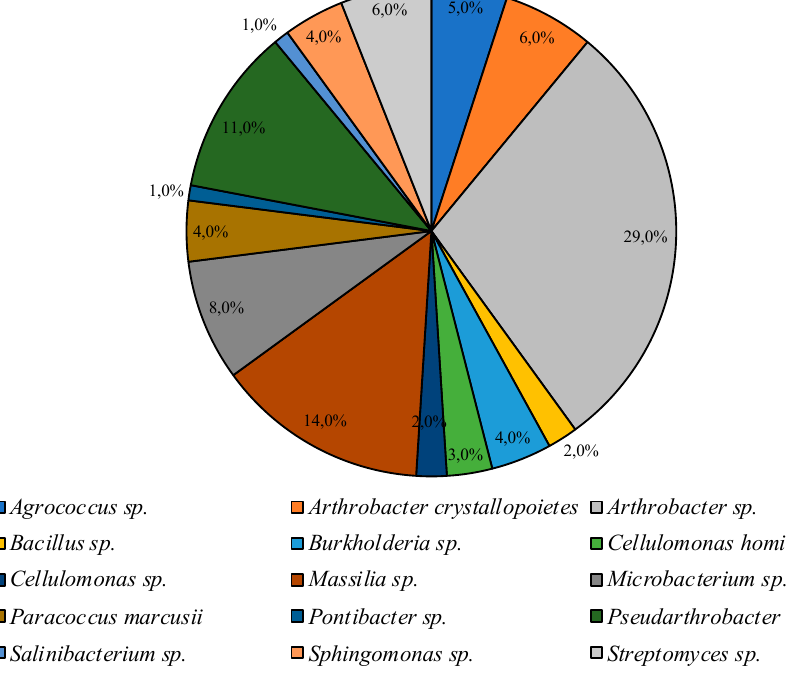
Figure 4. Structure of the culturable bacterial community isolated on CM medium at 25 °C.